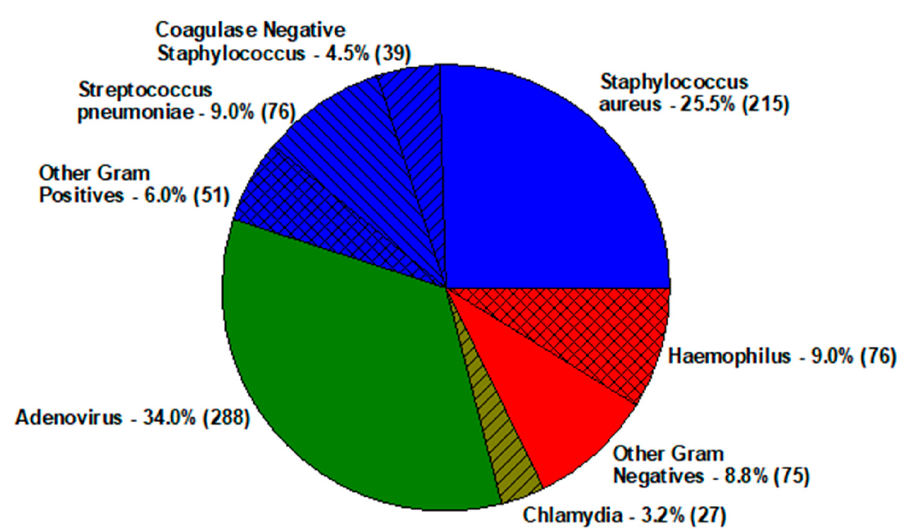
Figure 3. Distribution of infectious conjunctivitis pathogens.